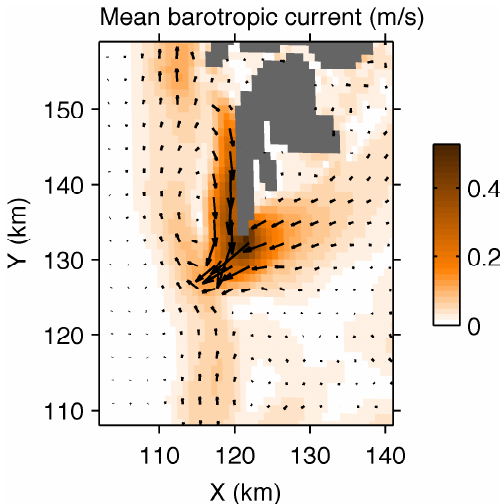
Fig. 14. Mean barotropic current near the cape.